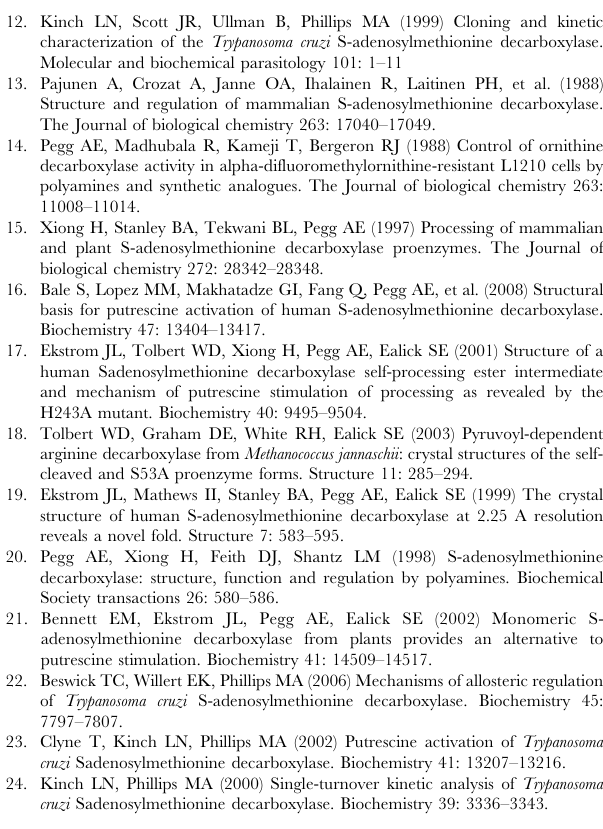
Figure S2 Unfolding studies of ADL in presence of urea. The changes in tertiary structure were monitored by fluorescence studies using tryptophan as intrinsic fluorophore and ANS as extrinsic fluorophore. (A–B) Effect of increasing concentration of urea on tryptophan fluorescence was monitored at tryptophan emission maxima 341 nm, shows increasing concentration of urea causes gradual red shift of ADL due to unfolding of protein with complete unfolding at 6 M urea. (C–D) ANS fluorescence emission spectra with increasing concentration of urea, monitored at 465 nm. Graph shows emission maxima increases with increase in concentration of urea up to 0.5 M urea, then gradually decreased with minima at 6 M urea, due to loss of hydrophobic patches. Figure S3 Unfolding studies of L. donovani ADL in presence of GdmCl. The changes in tertiary structure were monitored by fluorescence studies using tryptophan as intrinsic fluorophore and ANS as extrinsic fluorophore. (A–B) Effect of GdmCl on tryptophan fluorescence of L. donovani ADL monitored at 341 nm emission maxima. Graph shows increased concentra- tion of GdmCl causes unfolding of protein with maximum transition at 1.5 M GdmCl and protein gets fully exposed at 2 M concentration. (C–D) ANS fluorescence emission spectra with increasing concentration of GdmCl monitored at 465 nm shows emission maxima increases with increasing concentration of GdmCl up to 0.5 M GdmCl, and then gradually decreased to a minimum value at 4 M GdmCl. Figure S4 AD-ADL interaction observed from GST pull down assay. The cell lysate containing AD-GST construct (in